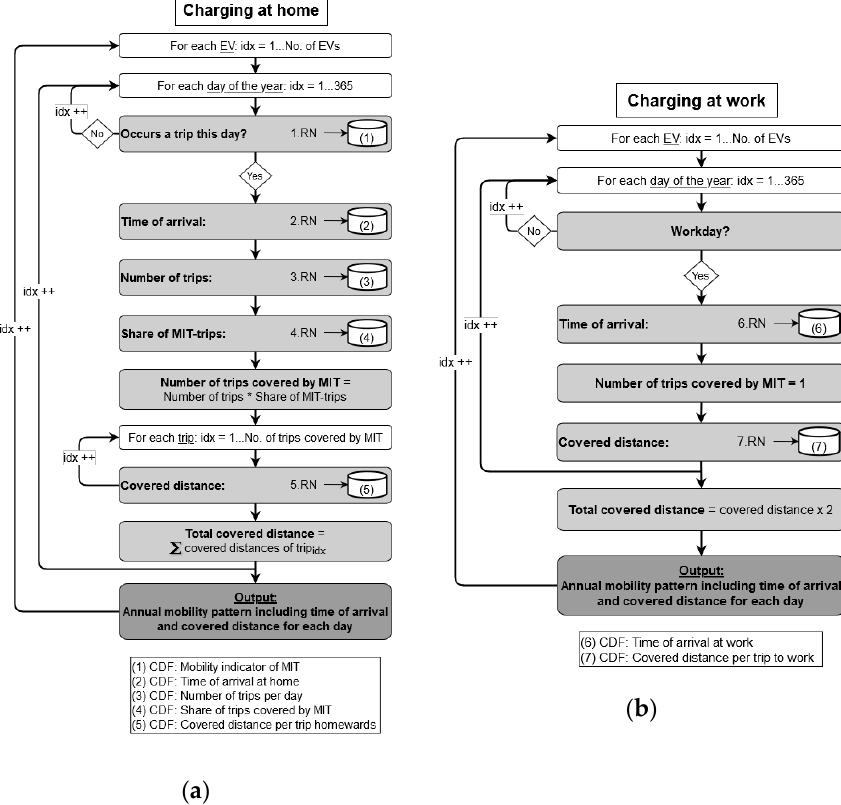
Figure A3. Probabilistic modeling of mobility patterns: charging at home ( a ) and charging at work ( b ).